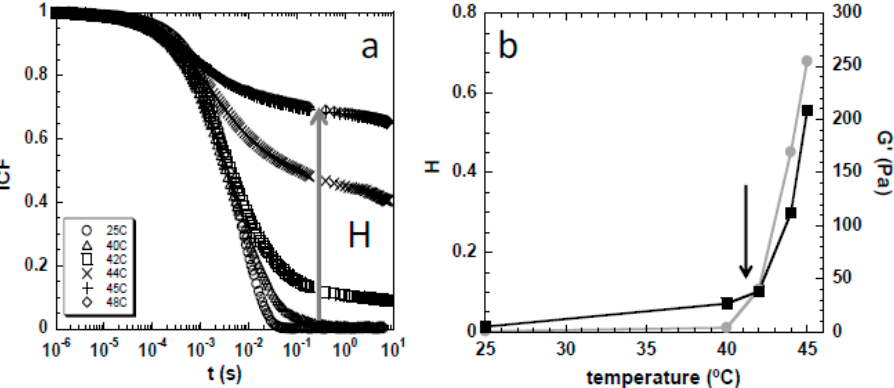
Figure 4. ( a ) Intensity correlation function (ICF) obtained with increasing temperature for the solution of 5 wt % MCC in NaOH(aq.), and ( b ) the corresponding H ( t = 1 s; grey circles) and G ′ ( ω = 100 rad/s; black squares) as a function of temperature. The arrow on the left indicates how the ICF plateaus (and the H parameter) evolve with temperature rise, while the arrow on the right indicates the inflection point ( Tg ), where both the H parameter and G ′ start increasing exponentially.